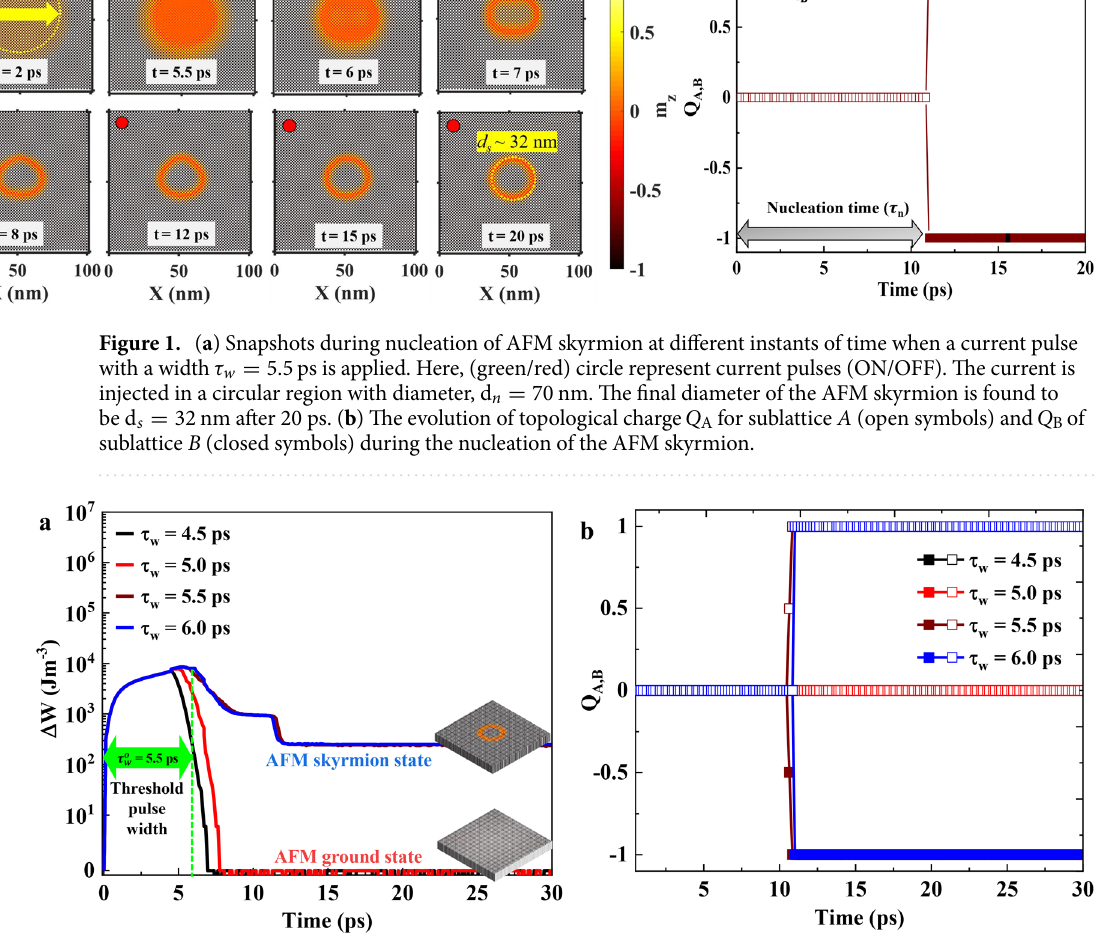
Figure 2. ( a ) Change in total energy density (cid:31) W during the nucleation of AFM skyrmion for varying pulse 4.5, 5.0, 5.5 , and 6.0 ps). ( b ) The corresponding evolution of topological charge Q A for sublattice widths ( τ w = A (open symbols) and Q B of sublattice B (closed